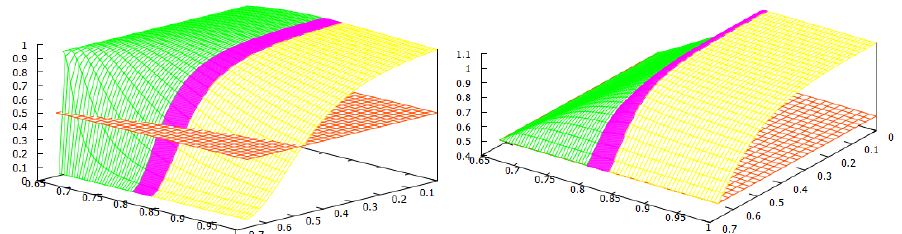
of country X j . Right : The social profit share Sh π S j